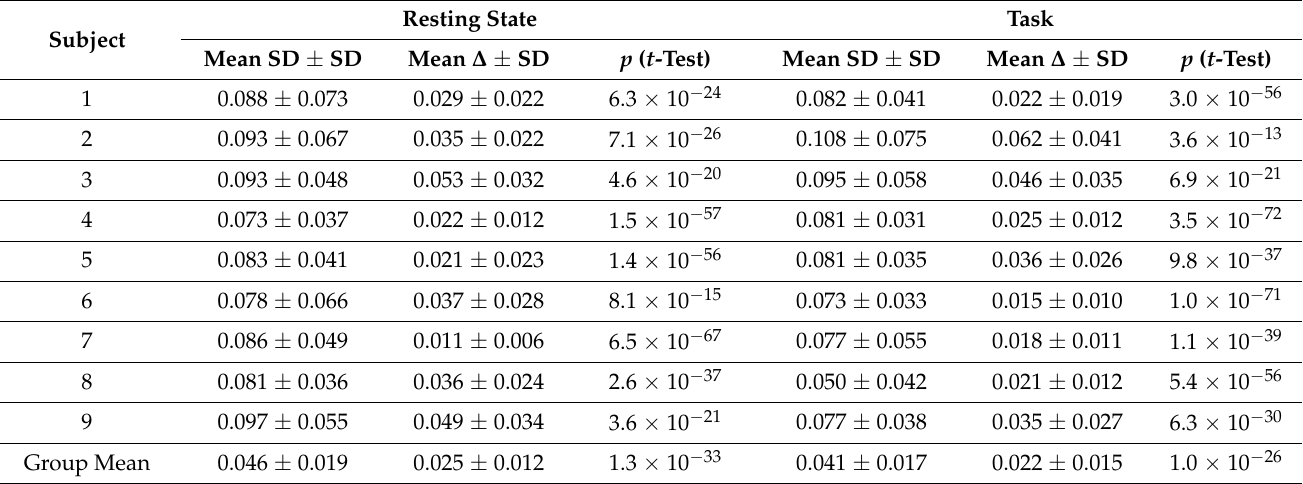
Table 2. The mean value of the distribution (Figure 2) averaged over all 200 r values for the standard deviation (SD) of R r and the absolute value of the difference between R r and R ( r ) (i.e., ∆ R = | R r − R ( r )|), respectively, for the resting and task states. Note that the last row shows these mean values computed with their corresponding group mean distributions in Figure 2 (the last plot in the second and fourth